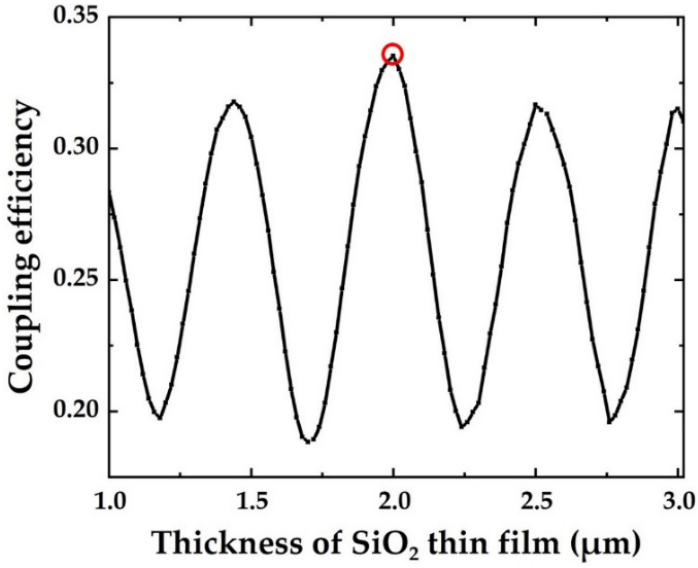
Figure 5. Coupling efficiency as a function of the SiO 2 cladding thickness. Figure 6a,b shows the coupling efficiencies as functions of Lx and Ly , respectively. The coupling efficiency decreases faster when Lx decreases than when Lx